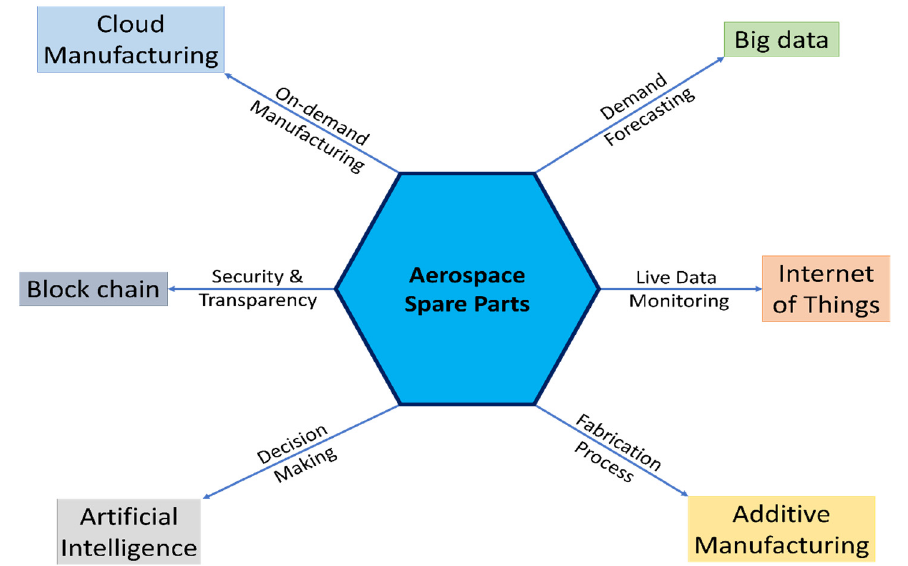
Figure 8. Digitalization of spare parts supply chain with industry 4.0.